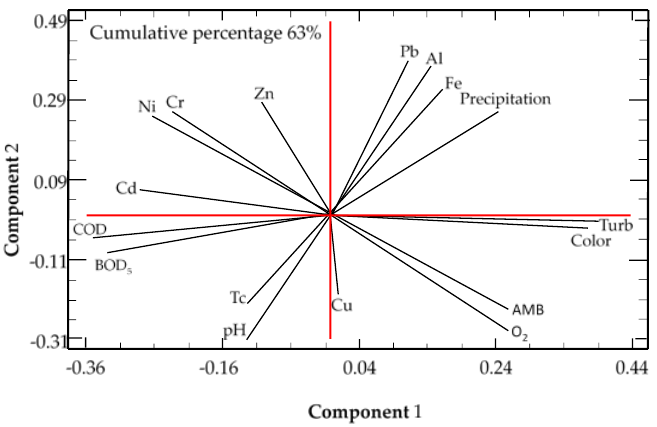
Figure 2. The average values of COD and BOD 5 in the Atoyac River, during the dry and rainy seasons. * HC = Highly Contaminated; C = Contaminated. Limits for COD are in red lines, and those for BOD 5 are in blue lines.